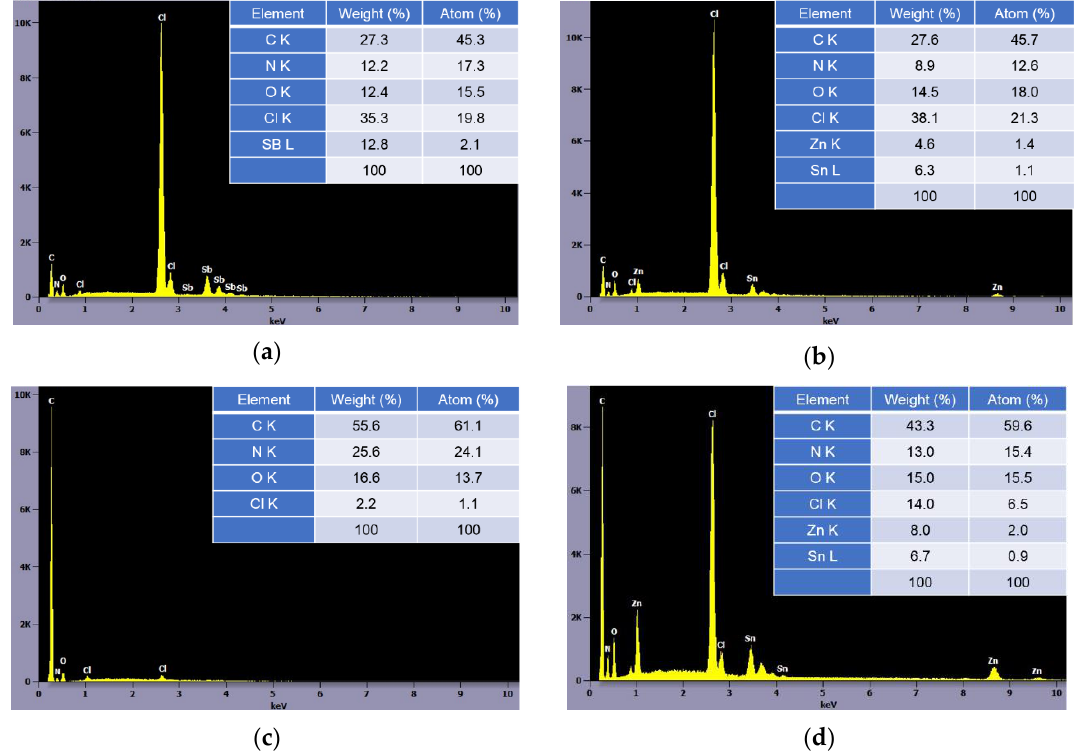
Figure 3. The EDX results of the surface of ( a ) PANVDC-ATO and ( b ) PANVDC-ZHS films and the char surface of ( c ) PANVDC-ATO and ( d ) PANVDC-ZHS films.